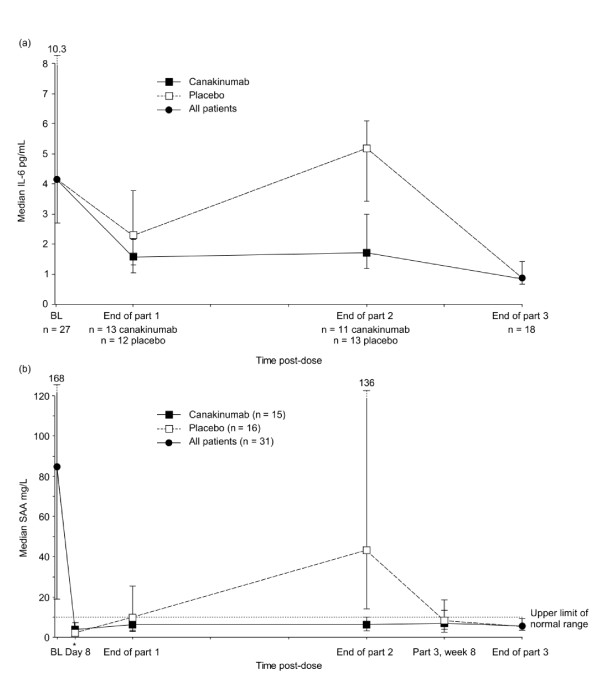
Interleukin (IL)-6 (a) and serum amyloid A (SAA) levels (b) over the course of the study by treatment group.a Data are presented as median (interquartile range) *1 week after the start of part 1. Upper limit of normal range for SAA was 10 mg/L.